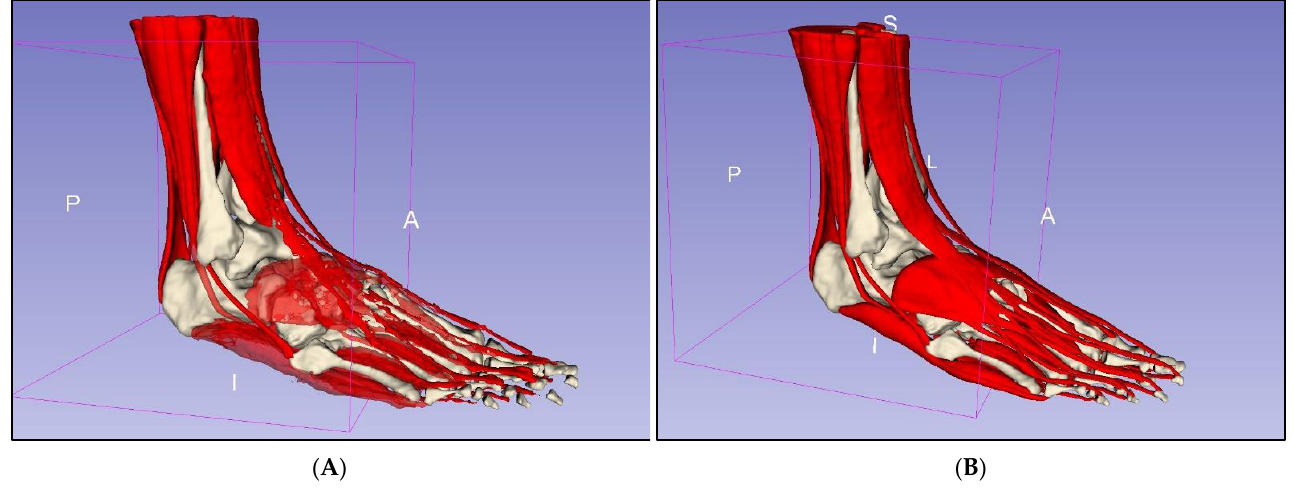
Figure 5. Segmentation of musculature. ( A ) Rough segmentation. ( B ) Segmented musculature after manual refinement. A—anterior, I—inferior, L—lateral, P—posterior, S—superior.